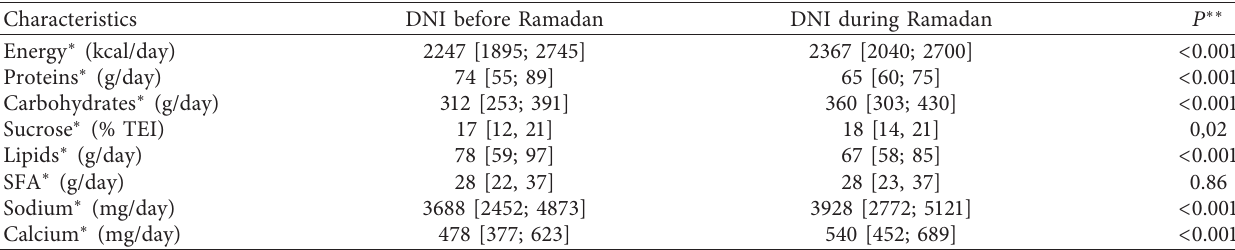
Table 4: Nutritional intake comparison before and during Ramadan ( n �